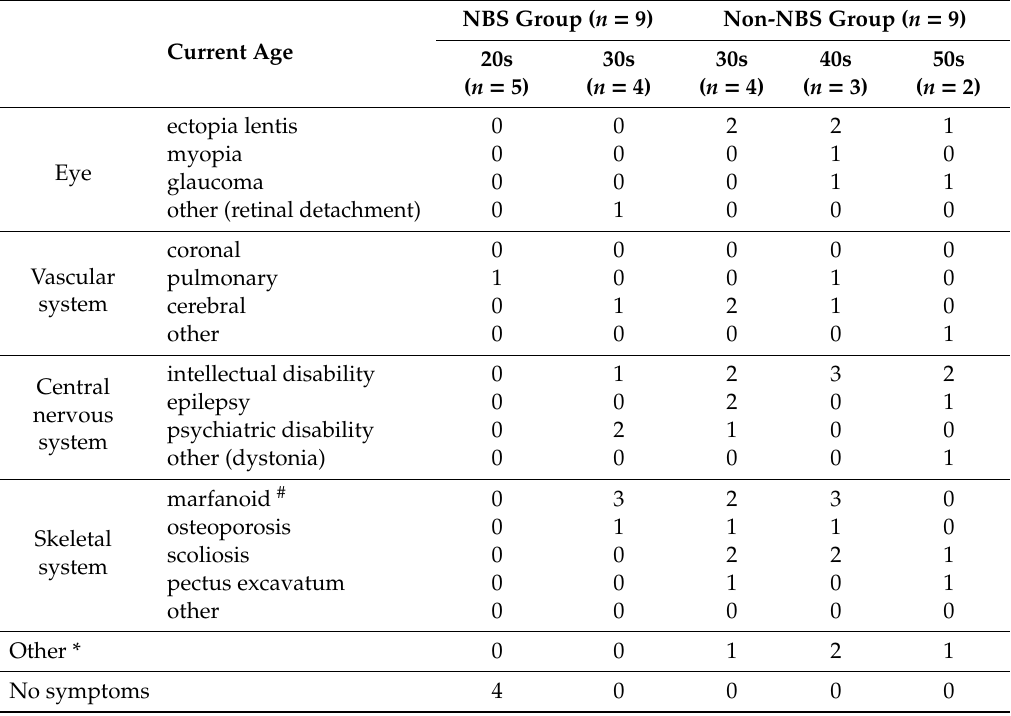
Table 2. Comparison of the major clinical symptoms in adult